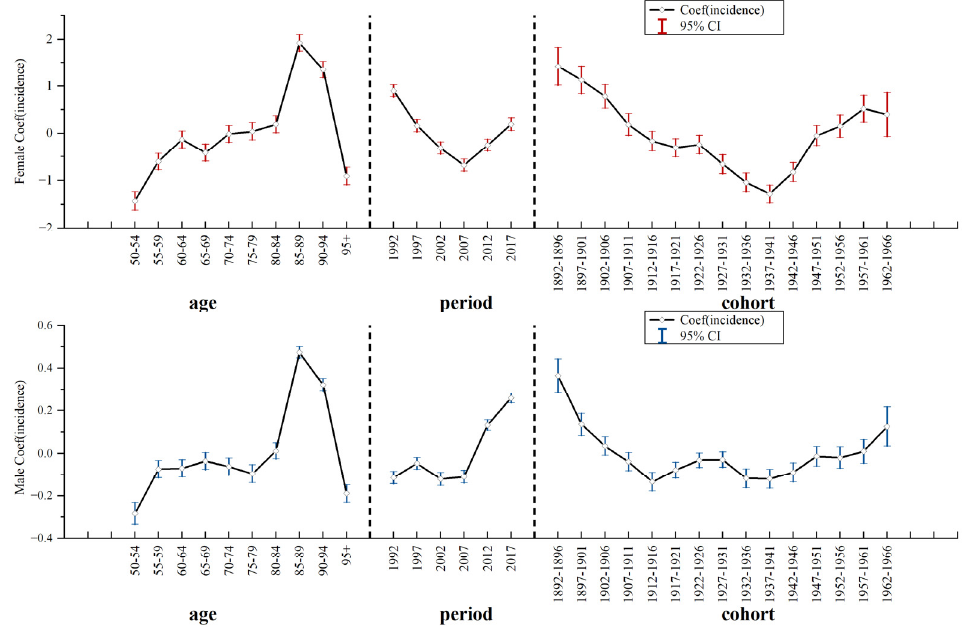
Figure 4. APC model analysis of nasopharyngeal carcinoma incidence among females and males in China.